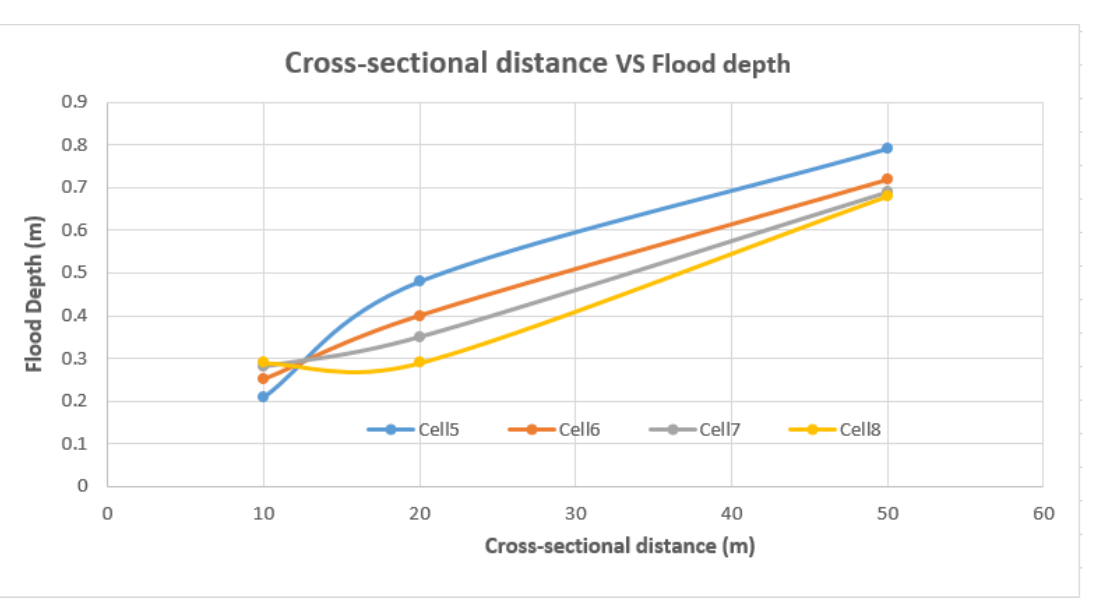
Table 4. Maximum flood depth values in different cells for certain cross sections in sub-reach K6 (varying Manning’s n value).